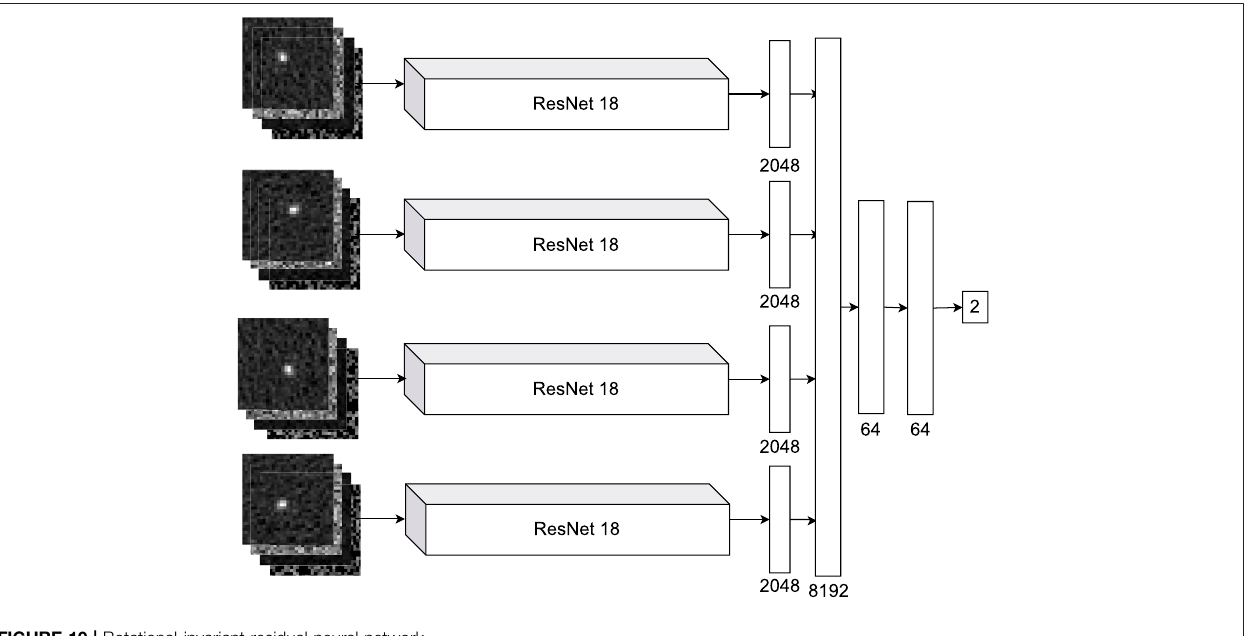
FIGURE 10 | Rotational-invariant residual neural network.